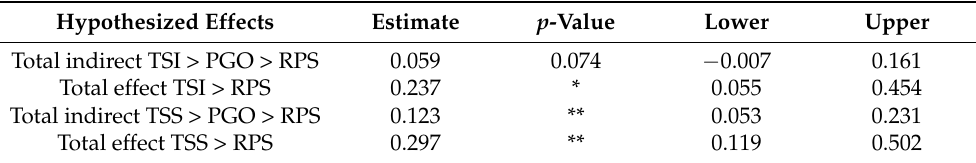
Table 6. Mediating effect among